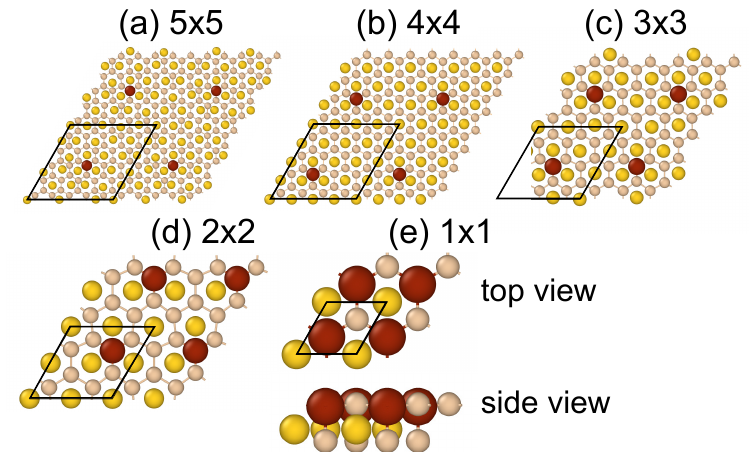
Figure 1. Structures of Fe-covered Au-supported planar silicene with a coverage of N = 2.0% ( a ), 3.1% ( b ), 5.6% ( c ), 12.5% ( d ), and 50.0% ( e ). Unit cells for each structure are marked by black rhombi.